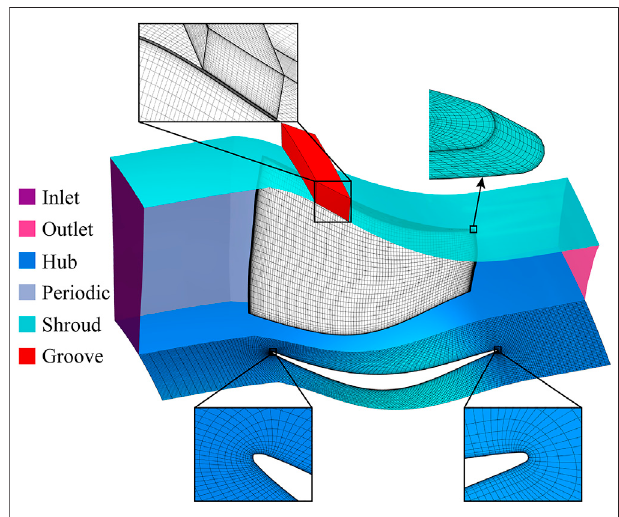
FIGURE 2 | Comparison of overall performance with different meshes.